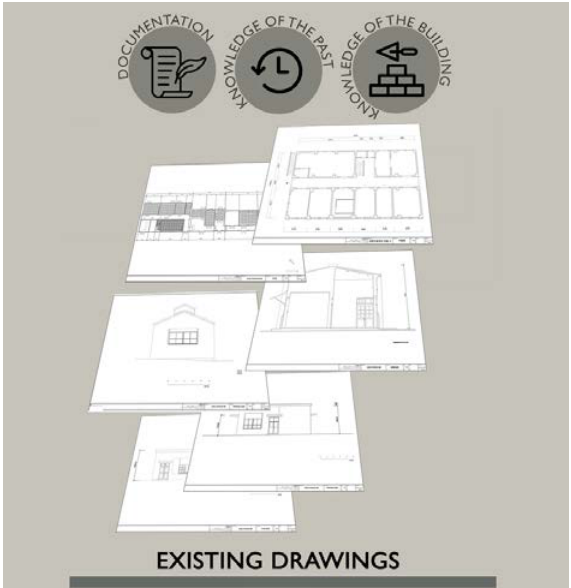
Figure 10: From exiting drawings to hypothesized Revit model.